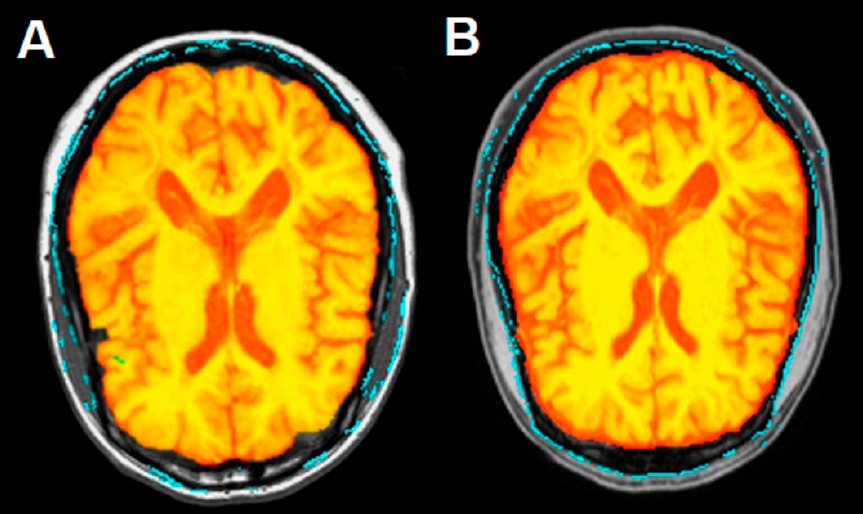
Figure 5. Pre-to-post registration axial images of the brain, before ( A ) and after ( B ) the DFPP procedure respectively, identified using the Siena tool of the FSL software. Yellow color indicates the brain parenchymal fraction, red color the ventricular system and subarachnoid spaces. Given the 2.14% reduction of total intracranial volume (TIV), note the expected prevalence of the red color in B indicating the involvement of subarachnoid spaces, with TIV = 1300.4 mL with respect to A with TIV = 1328.8 mL.